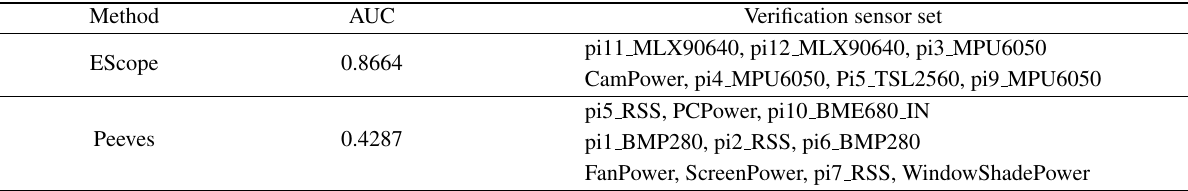
Table 5 Radiator off verification sensor